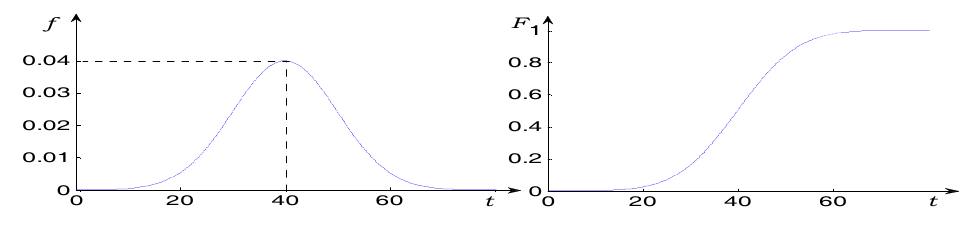
Figure 8. Probability density function and probability distribution of communication delay.